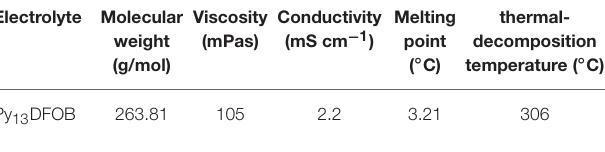
TABLE 1 | Physical characteristics of Py 13 DFOB.